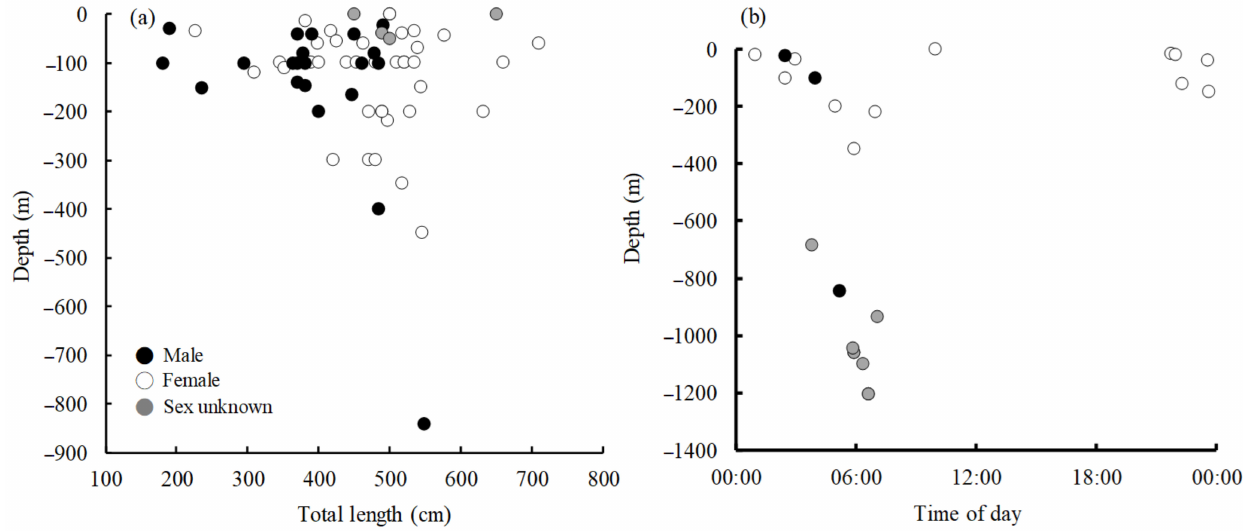
Figure 7. Vertical movement of M. pelagios . ( a ) The M. pelagios caught or sighted from different depths in size ( n = 64). ( b ) Temporal vertical movement of M. pelagios ( n =